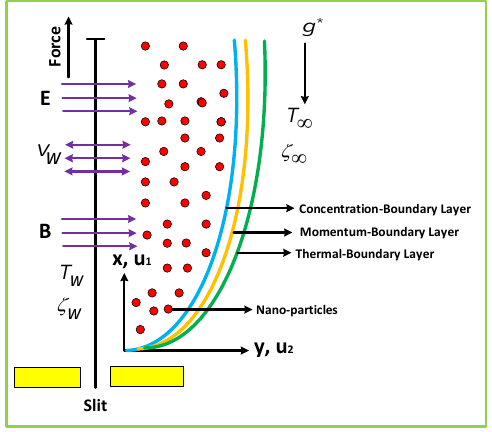
Figure 1. A schematic configuration with coordinate